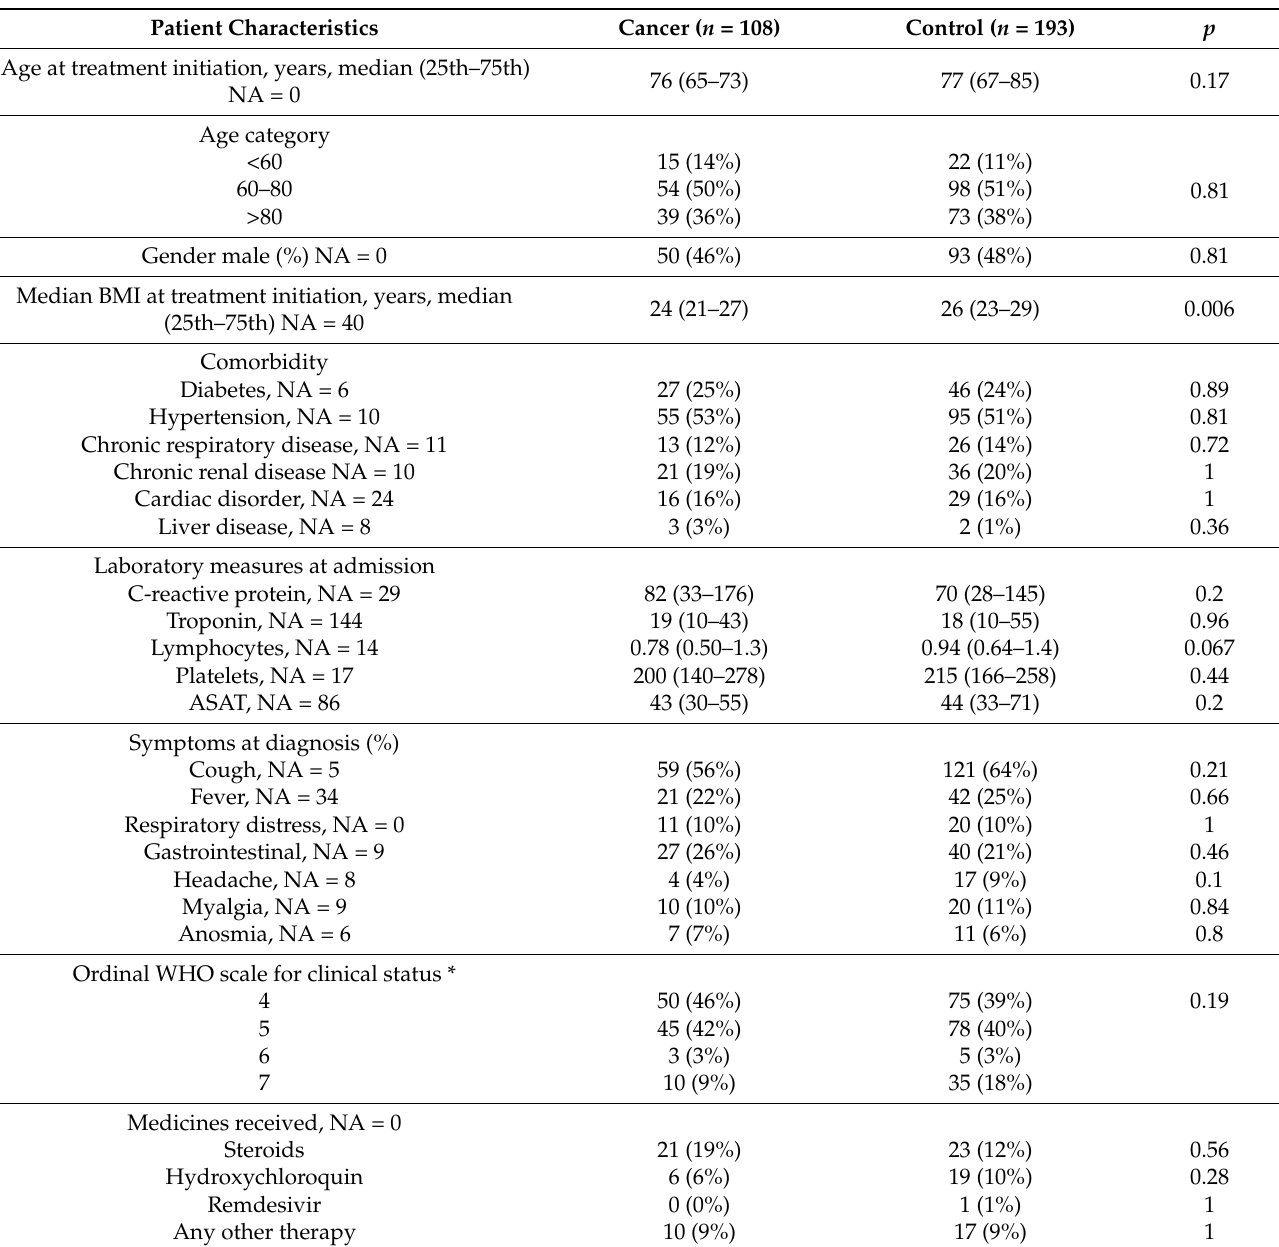
Table 1. Patients’ baseline